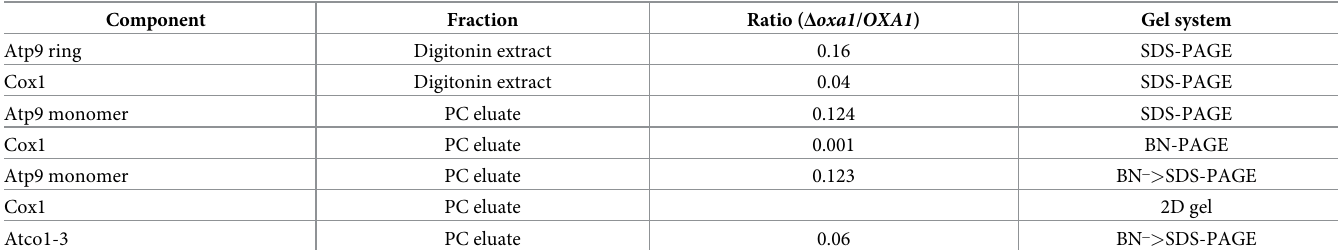
Table 1. Ratios of Atp9, Cox1 and Atco in strains with and without the oxa1 null allele.